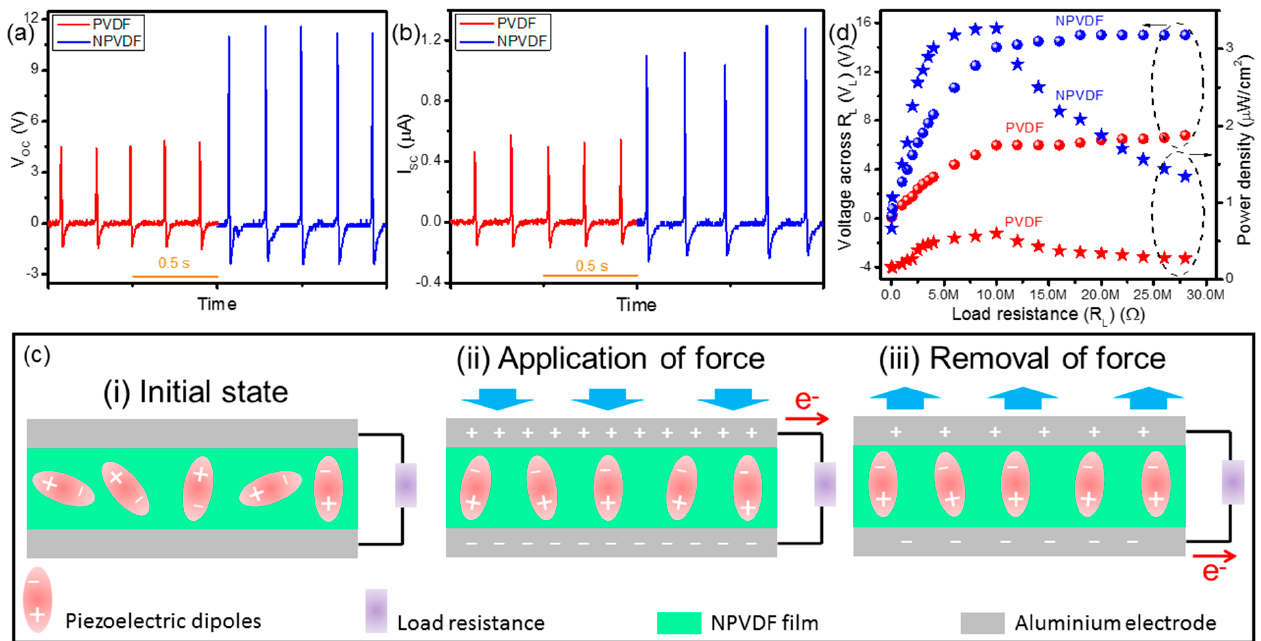
Figure 9. Output ( a ) V OC and ( b ) I SC from the PVDF and NPVDF-based PENGs. ( c ) Mechanism of piezoelectric energy harvesting. ( d ) R L -dependent V L and power density of the fabricated PENGs.